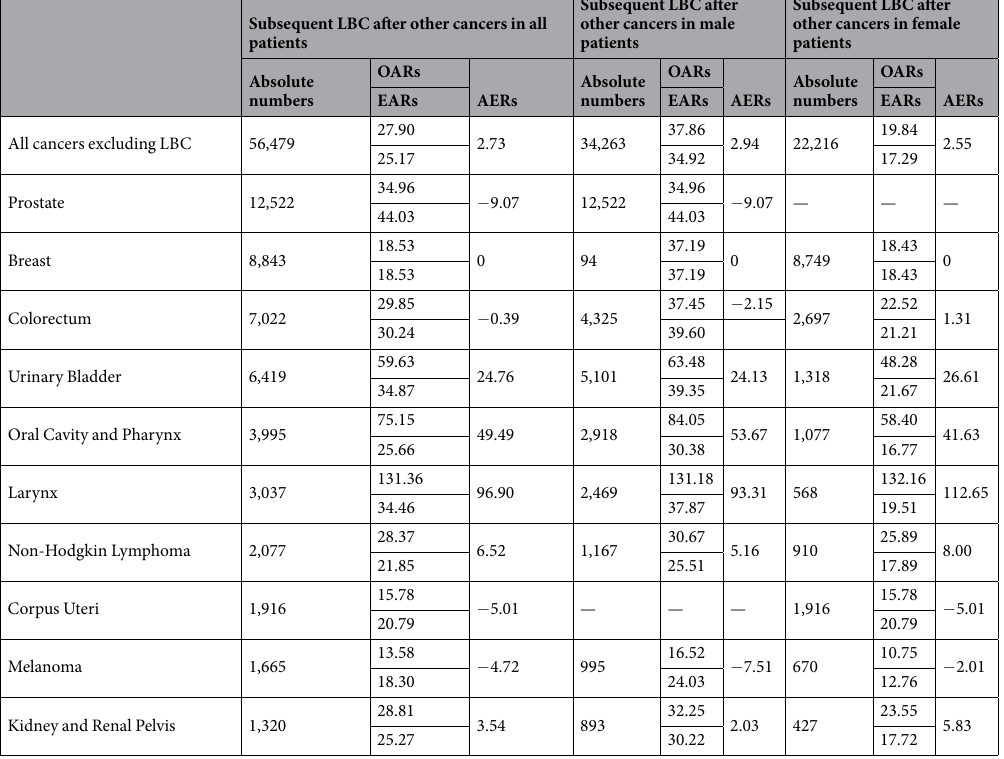
Table 3. OARs, EARs, and AERs of subsequent LBCs after other cancers. Abbreviations: SPC, subsequent primary cancer; LBC, lung and bronchus cancer; OAR, observed annual risk; EAR, expected annual risk; AER, Annual excess